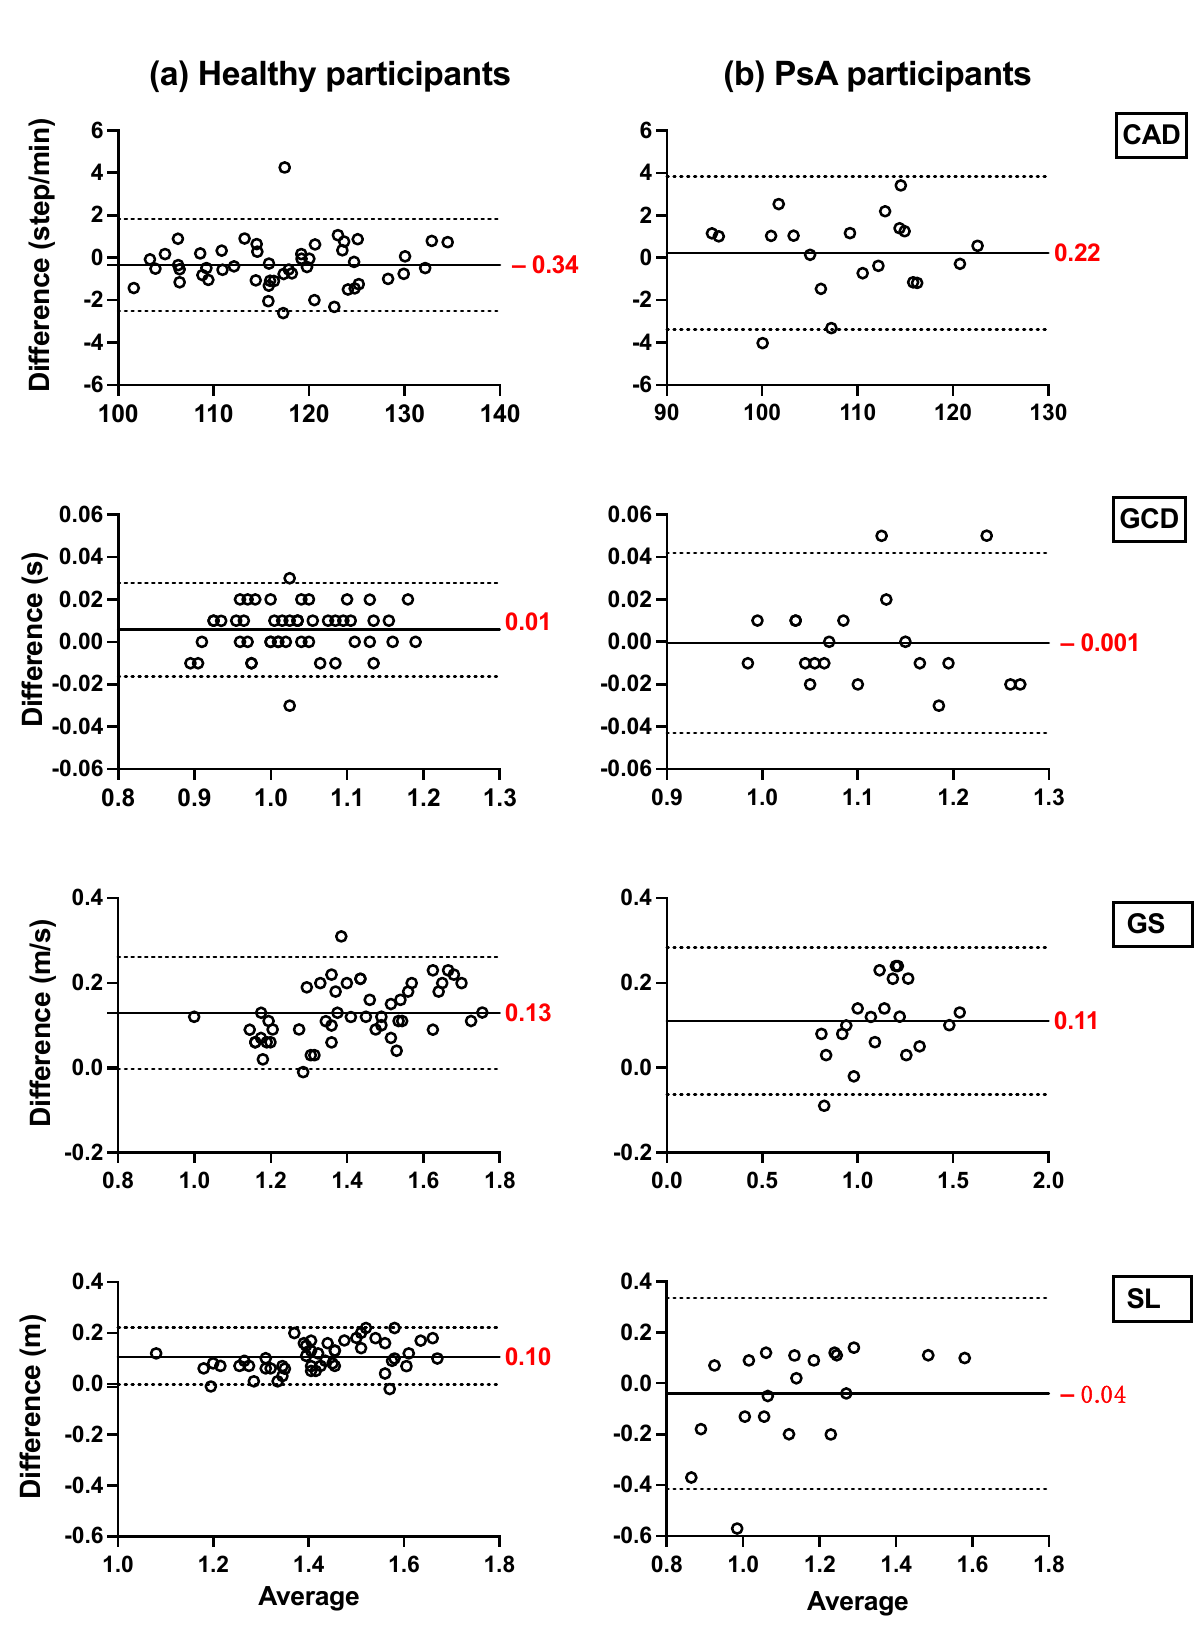
Figure 5. Agreement between the TEADRIP applied to the IMU-instrumented sock recordings and the Mobility Lab system. Bland–Altman plots of the differences between the IMU-instrumented sock and the Mobility Lab system in the spatio-temporal estimations measured for overground walking in ( a ) healthy and ( b ) PsA participants. The solid lines indicate the mean test-retest differences (bias) and the dashed lines indicate the upper and lower 95% limits of agreement (1.96 SD of the